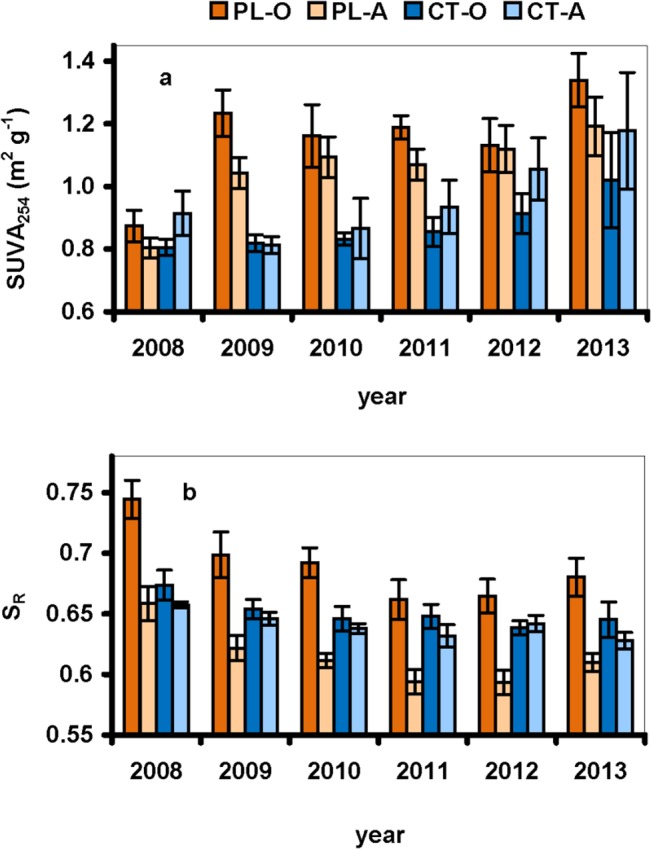
Annual average (n = 8–9 for each year) values of (a) the ratio between S275–295 and S350–400 slopes (SR), and (b) the specific absorbance of dissolved organic carbon at 254 nm (SUVA254) in water extracts from the O and A soil horizons at the Plešné (PL) and Čertovo (CT) plots.